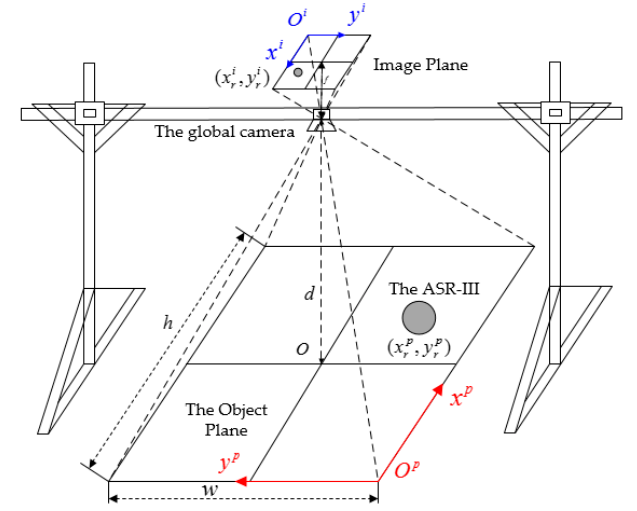
Figure 18. The vision localization system and the global camera. The gray circle indicates the ASR-III.